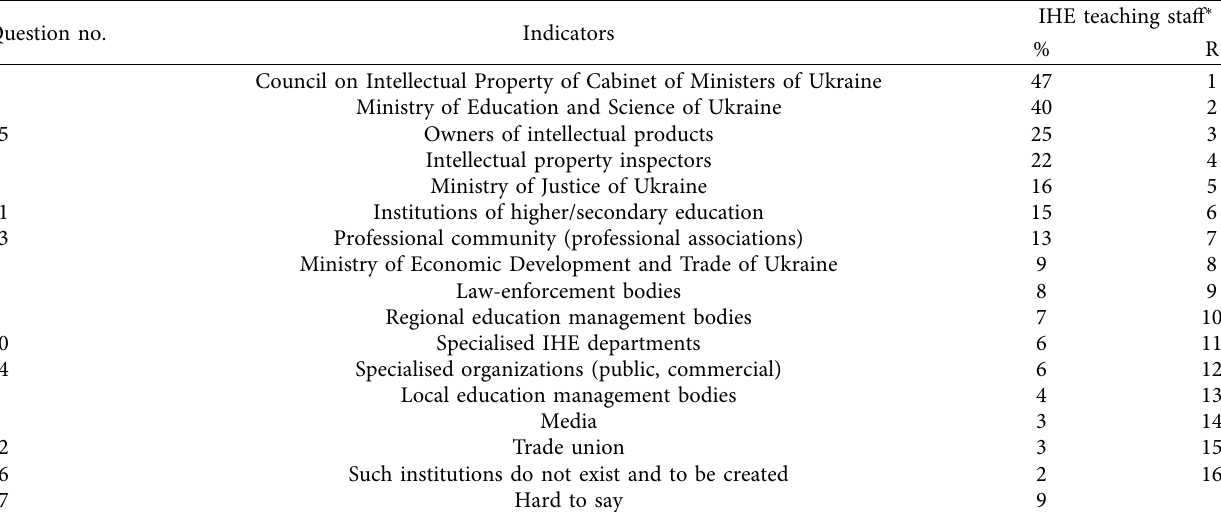
Table 4: Distribution of responsibility for IPR protection.